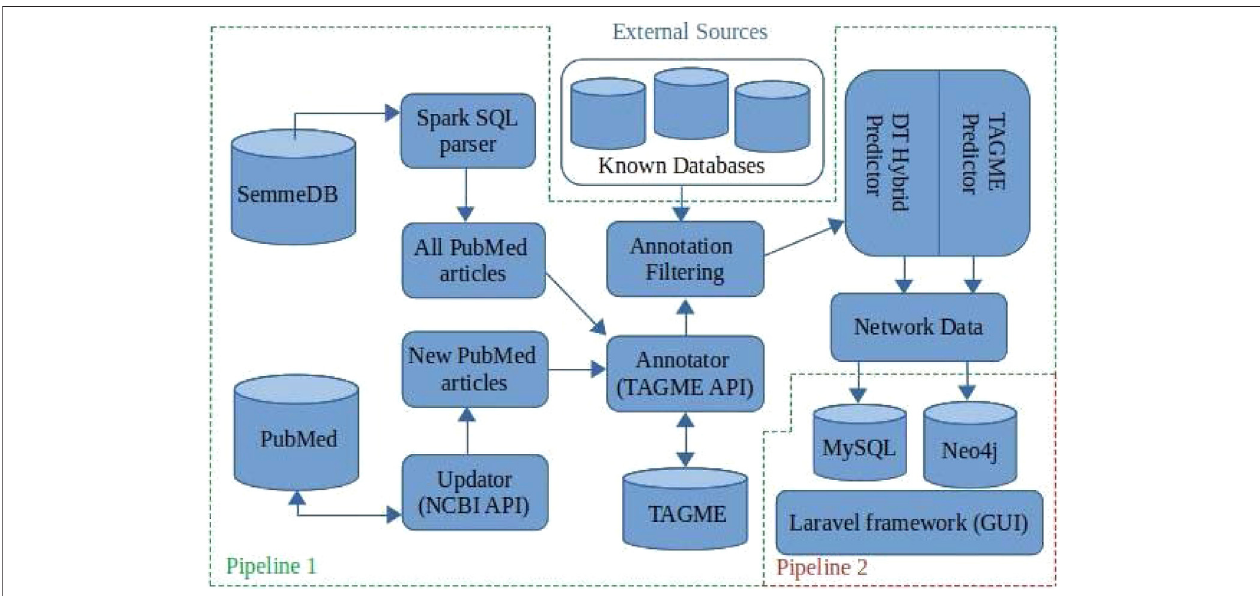
FIGURE 1 | BioTAGME pipelines: The fi rst one pipeline is the core of the project. It transforms the whole set of PubMed abstracts within nodes and edges of the knowledge graph. It has been implemented in Scala e Spark. The seconds pipeline, allows a user to extract information from the graph. It has been implemented using Laravel and